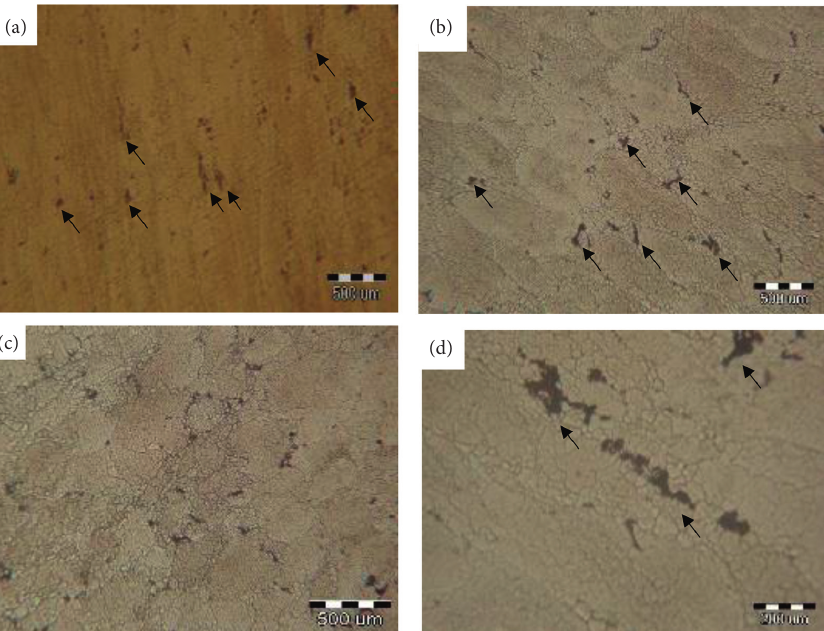
Figure 7: OM images of microstructure of (a) sample 1 (b) sample 2 (c) sample 3 (d) higher magnification of sample 2.